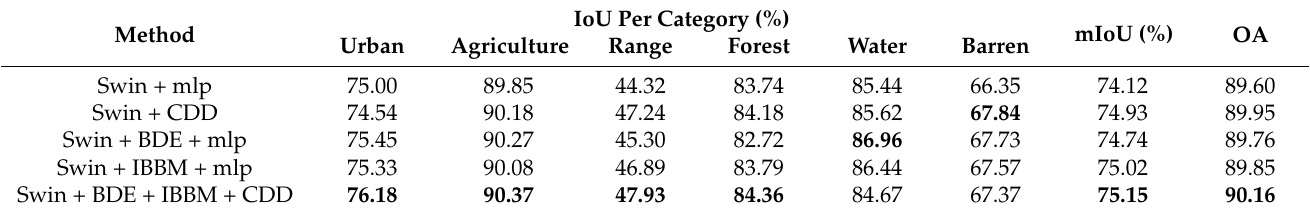
Table 4. The ablation experiments on the DeepGlobe dataset evaluated by mIoU (%) and OA (%) about the methopds. We employed the overall accuracy (OA), Intersection over Union (IoU) of Per Category and the mean Intersection over Union (mIoU) to evaluate model